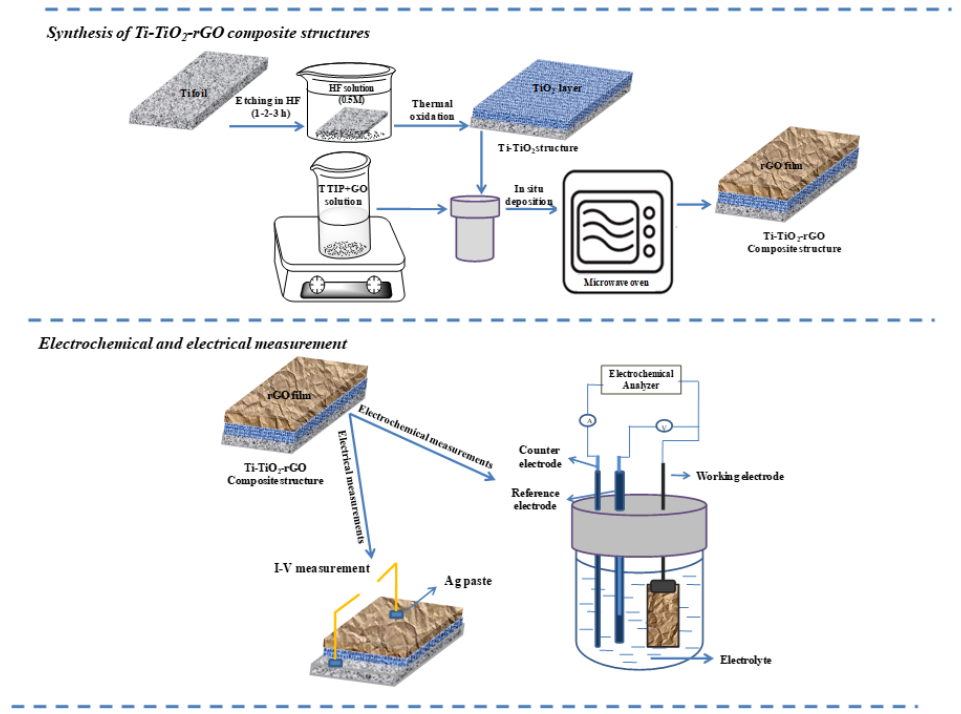
Figure 1. Schematic illustration of the achievement process for composite structures.